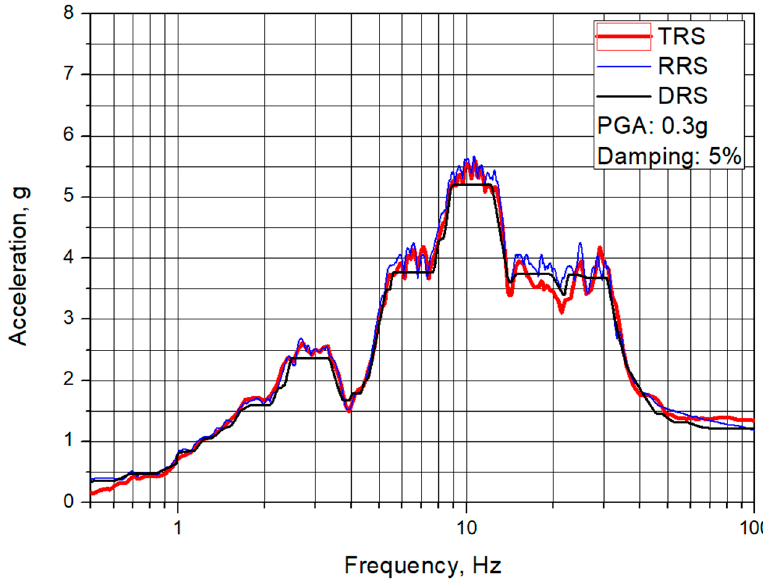
Figure 4. Design response spectrum used in tests (PGA = 0.3 g).